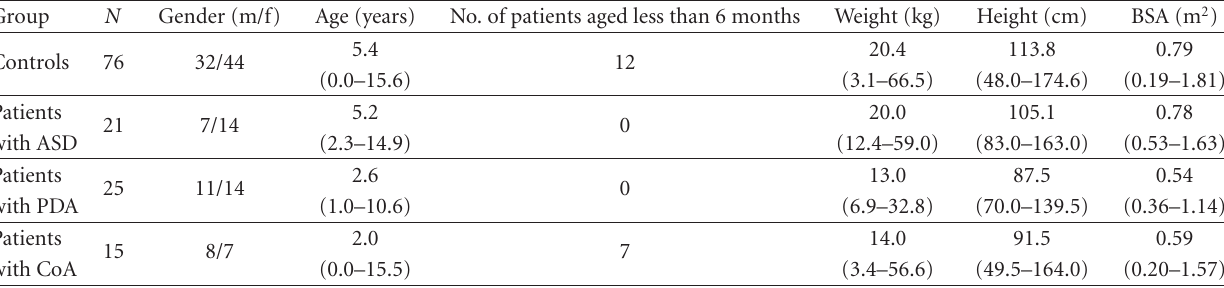
Table 1: Characteristics of subjects in the study groups at baseline. Values are expressed as median